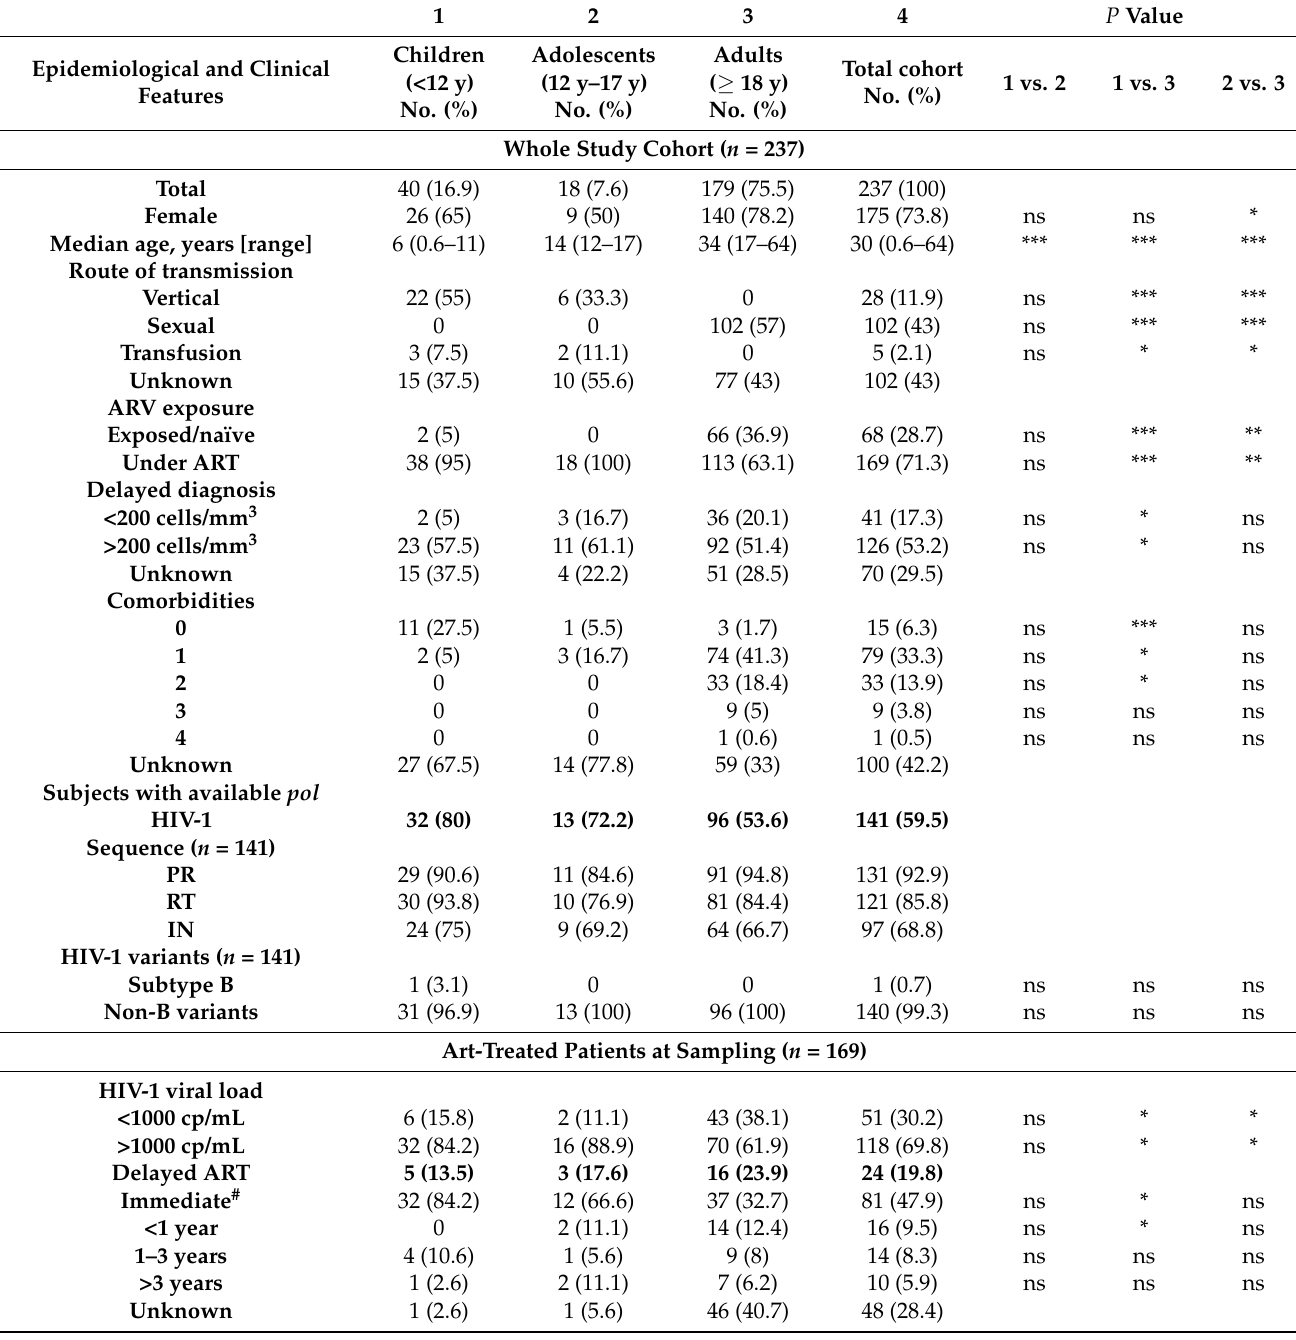
Table 1. Epidemiological and virological characteristics of the 237 individuals from EG with confirmed HIV-1 diagnosis in